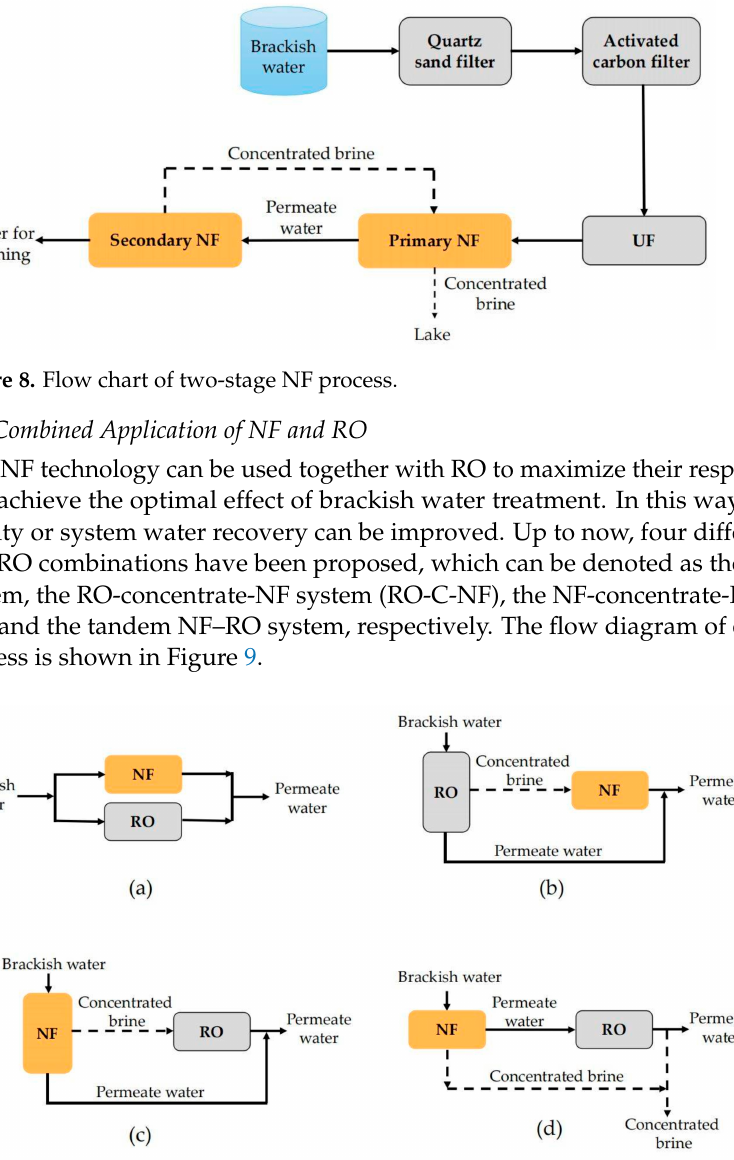
Figure 9. Schematic diagram of four hybrid systems configuration: ( a ) parallel NF/RO system; ( b ) RO-C-NF system; ( c ) NF-C-RO system; ( d ) tandem NF–RO system.